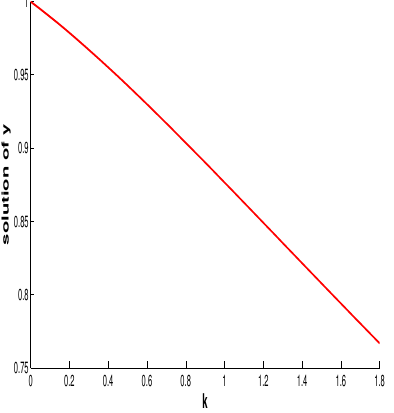
Figure 11. Relationship between the fear effect intensity and the final size of the